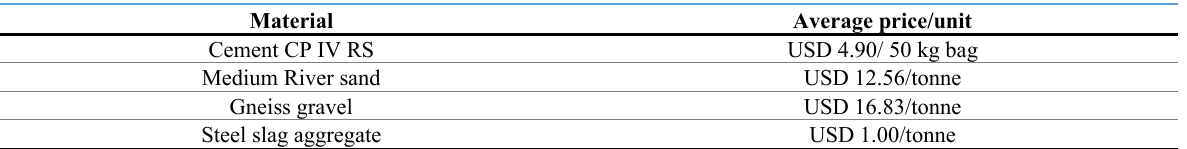
Table 7. Current prices of the concrete inputs in Brazil (reference year: